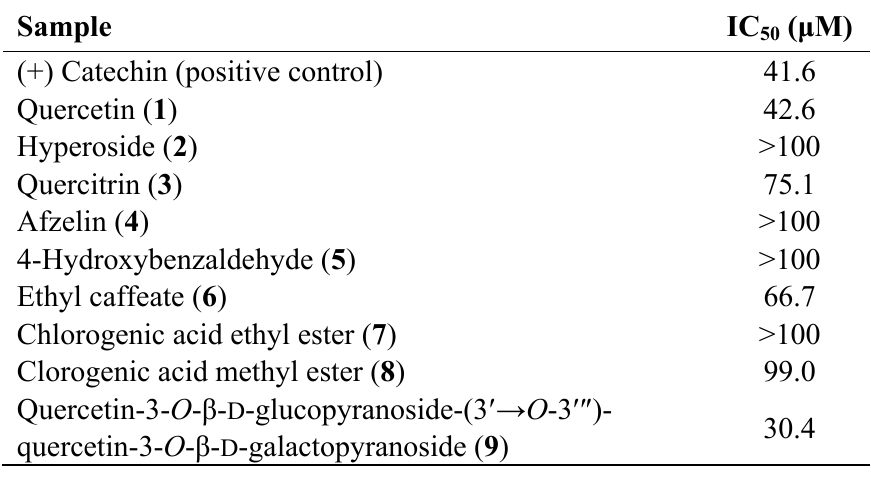
Table 1. Superoxide anion radical (O M.